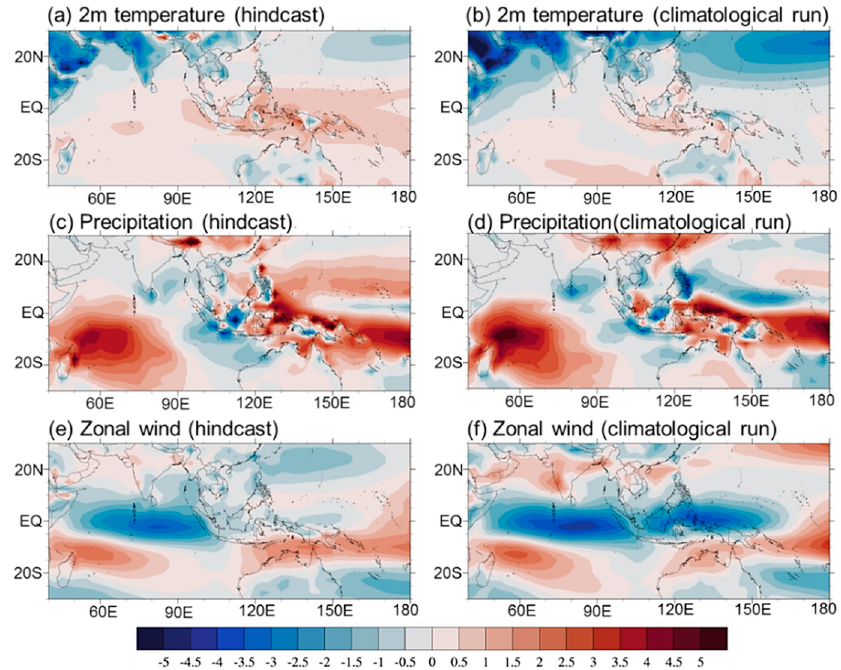
Figure 1. November–April bias of climatological T2m (K), precipitation (mm day − 1 ), and surface zonal wind (m s − 1 ) from the GS5 hindcast data ( a,c,e ) and the GS5 climatological run ( b,d,f ).